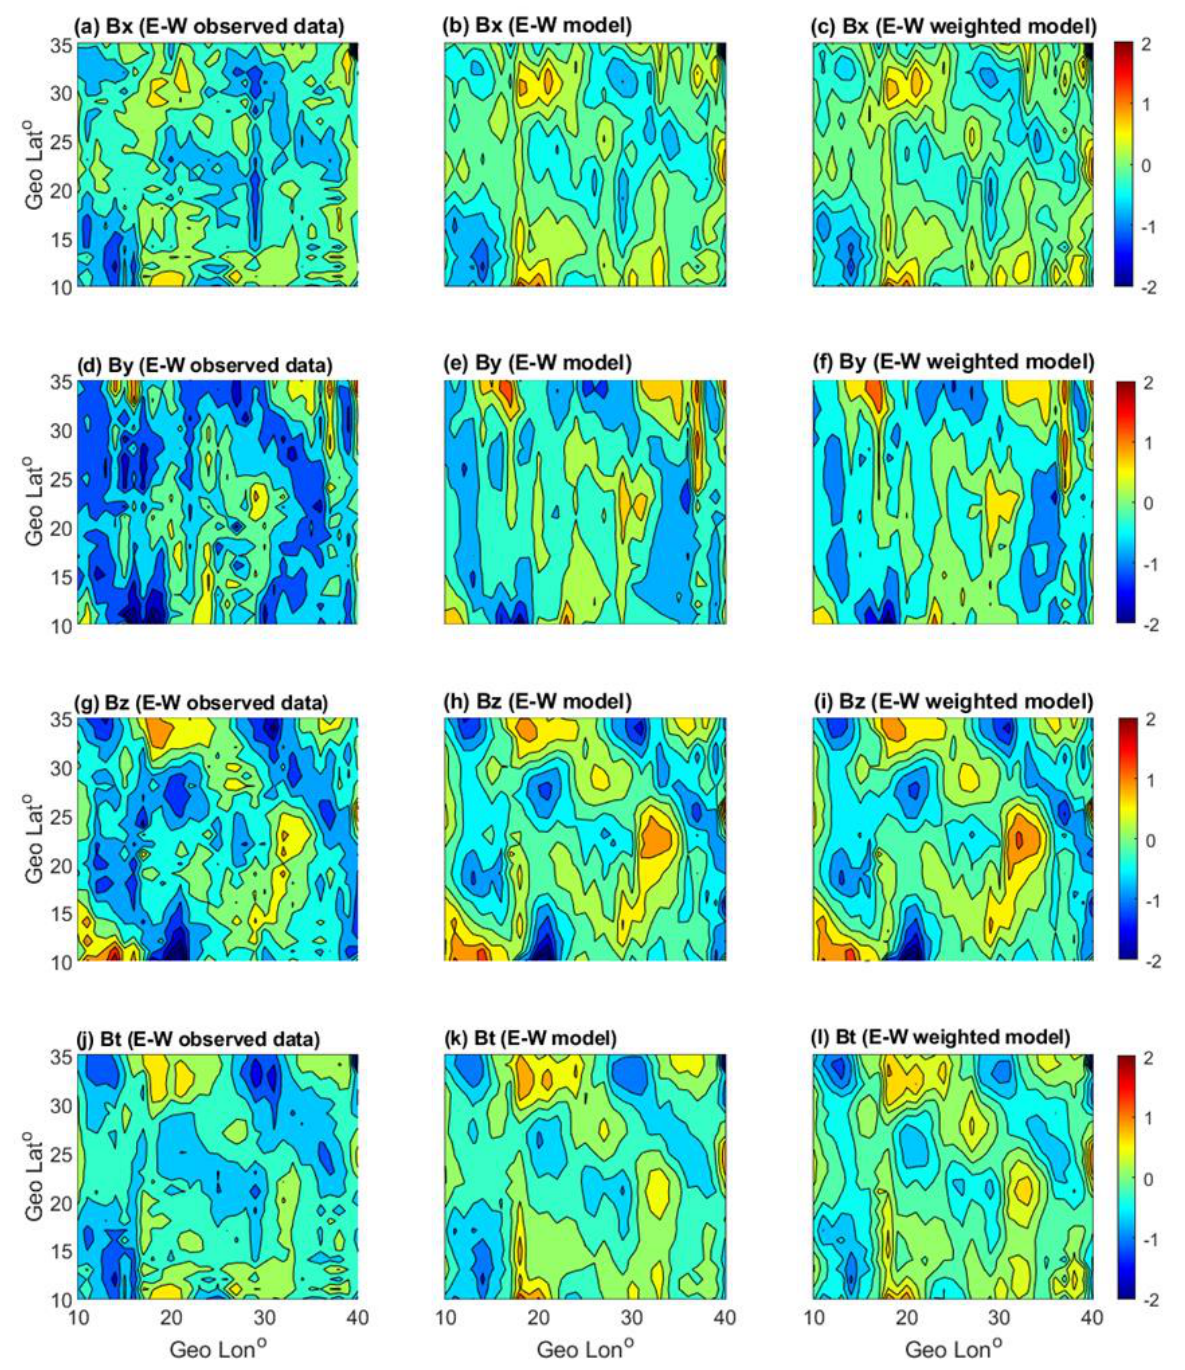
Figure 6. The 𝛁𝑩 𝒙 , 𝛁𝑩 𝒚 , 𝛁𝑩 𝒛 and 𝛁𝑩 𝒕 components of E – W direction for the observed, modeled, and weighted